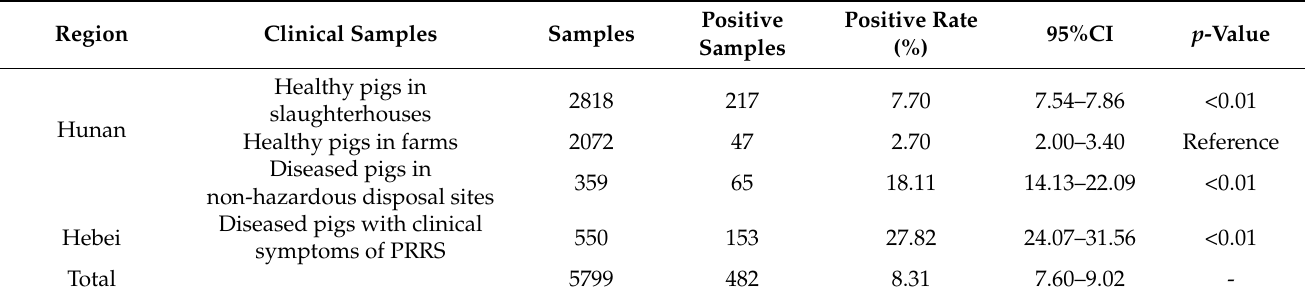
Table 2. Molecular detection of PRRSV among tissue samples collected from Hunan and Hebei provinces in